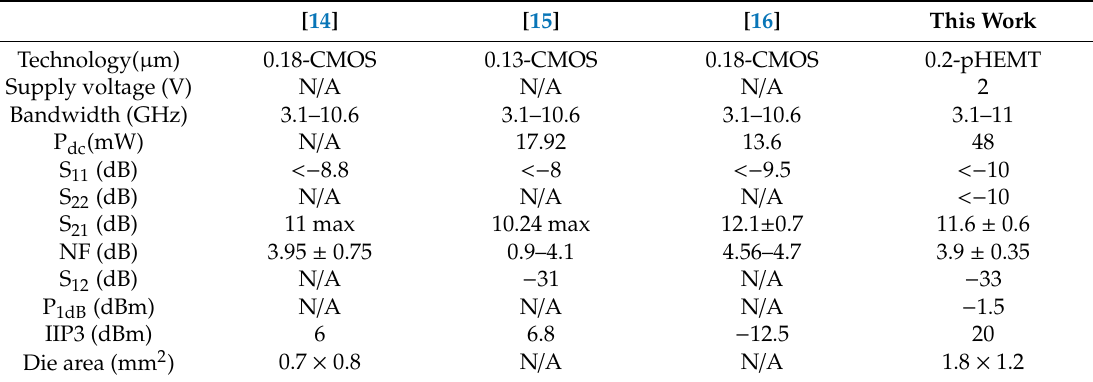
Table 3. UWB LNA performance